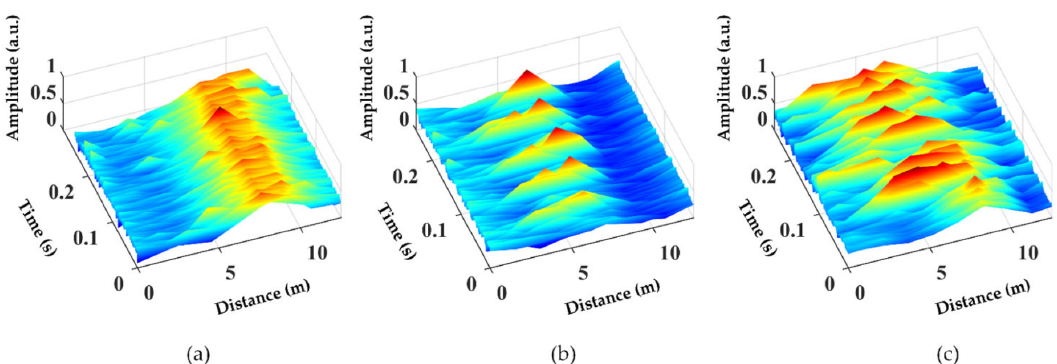
Figure 3. Time–space domain diagrams of three typical disturbance events: ( a ) hammer, ( b ) air pick, and ( c ) excavator.